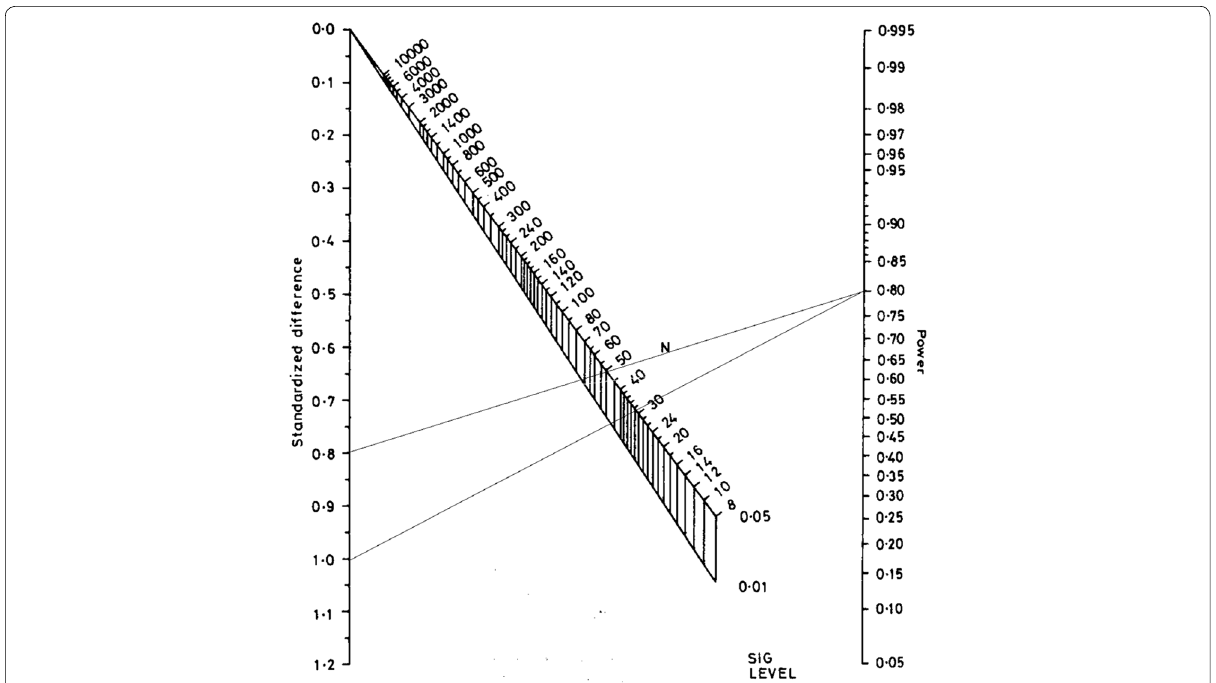
Fig. 3 Altman’s nomogram sample size calculation